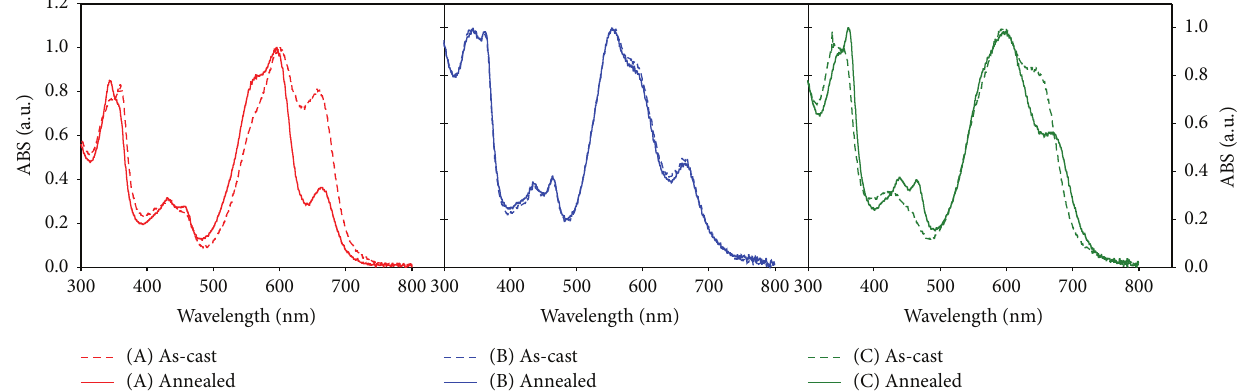
Figure 5: Normalized UV-Vis absorption spectra of the as-cast (dashed lines) and annealed at 140 ∘ C (solid lines) DPP:PC 60 BM blend